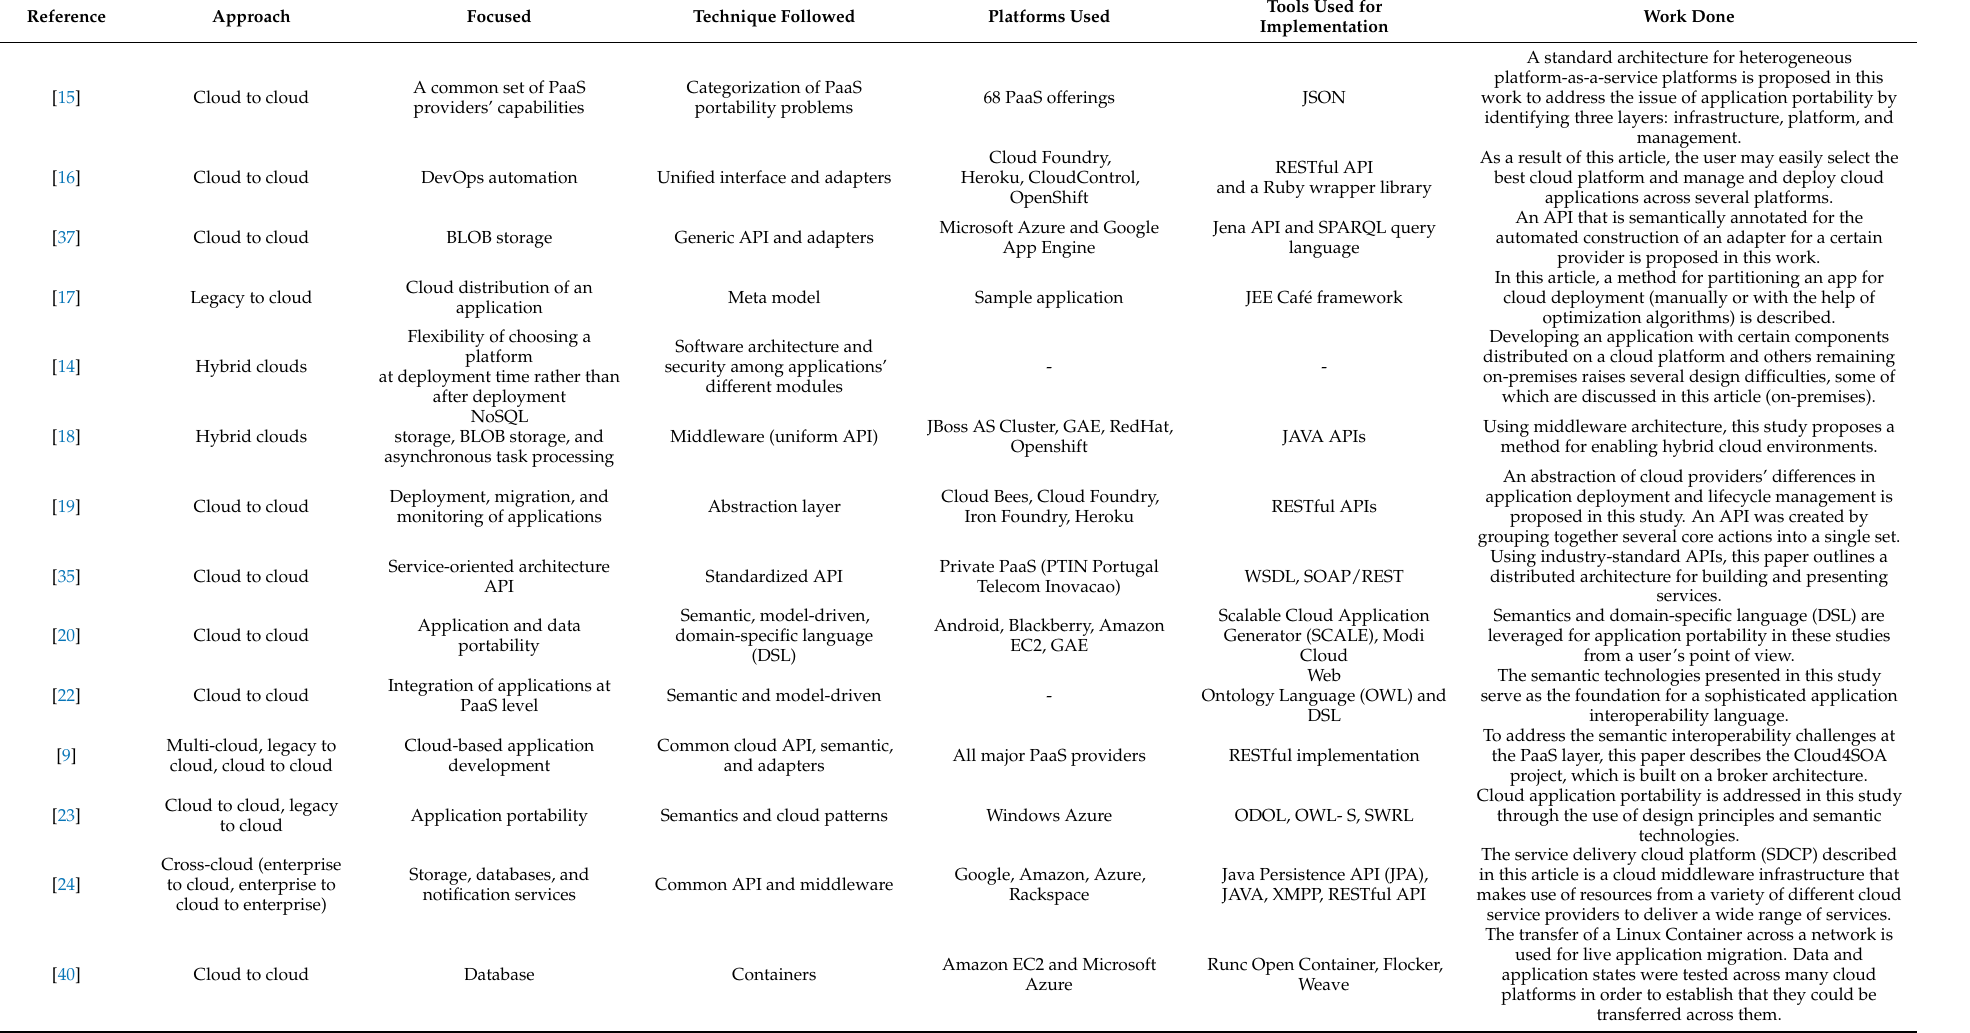
Table 1. Comparative analysis of solutions for application